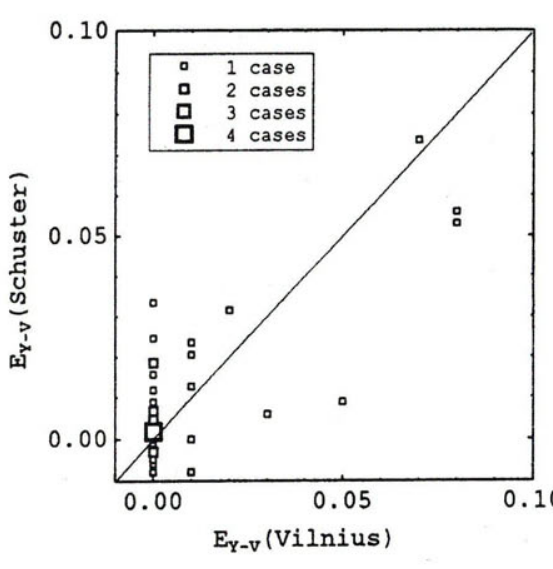
Fig. 5. Comparison of E